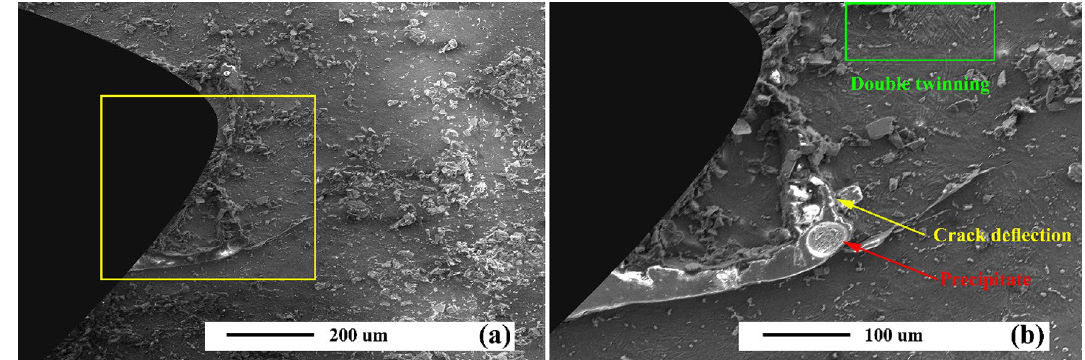
Figure 22. ( a ) SEM micrograph of aged AZ31/10%SiC after thermal cycles at 150 °C, and ( b ) higher